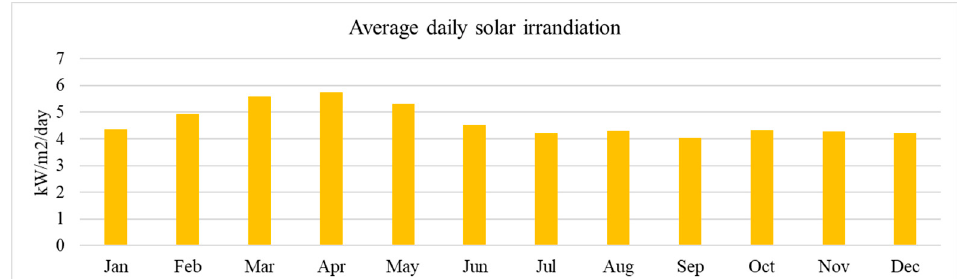
Figure 9. Monthly average daily solar irradiation for the assumed system location.